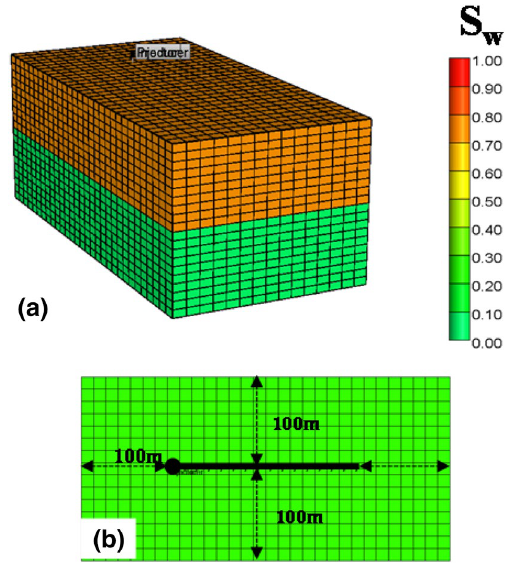
Fig. 3 The sketch map for the numerical model